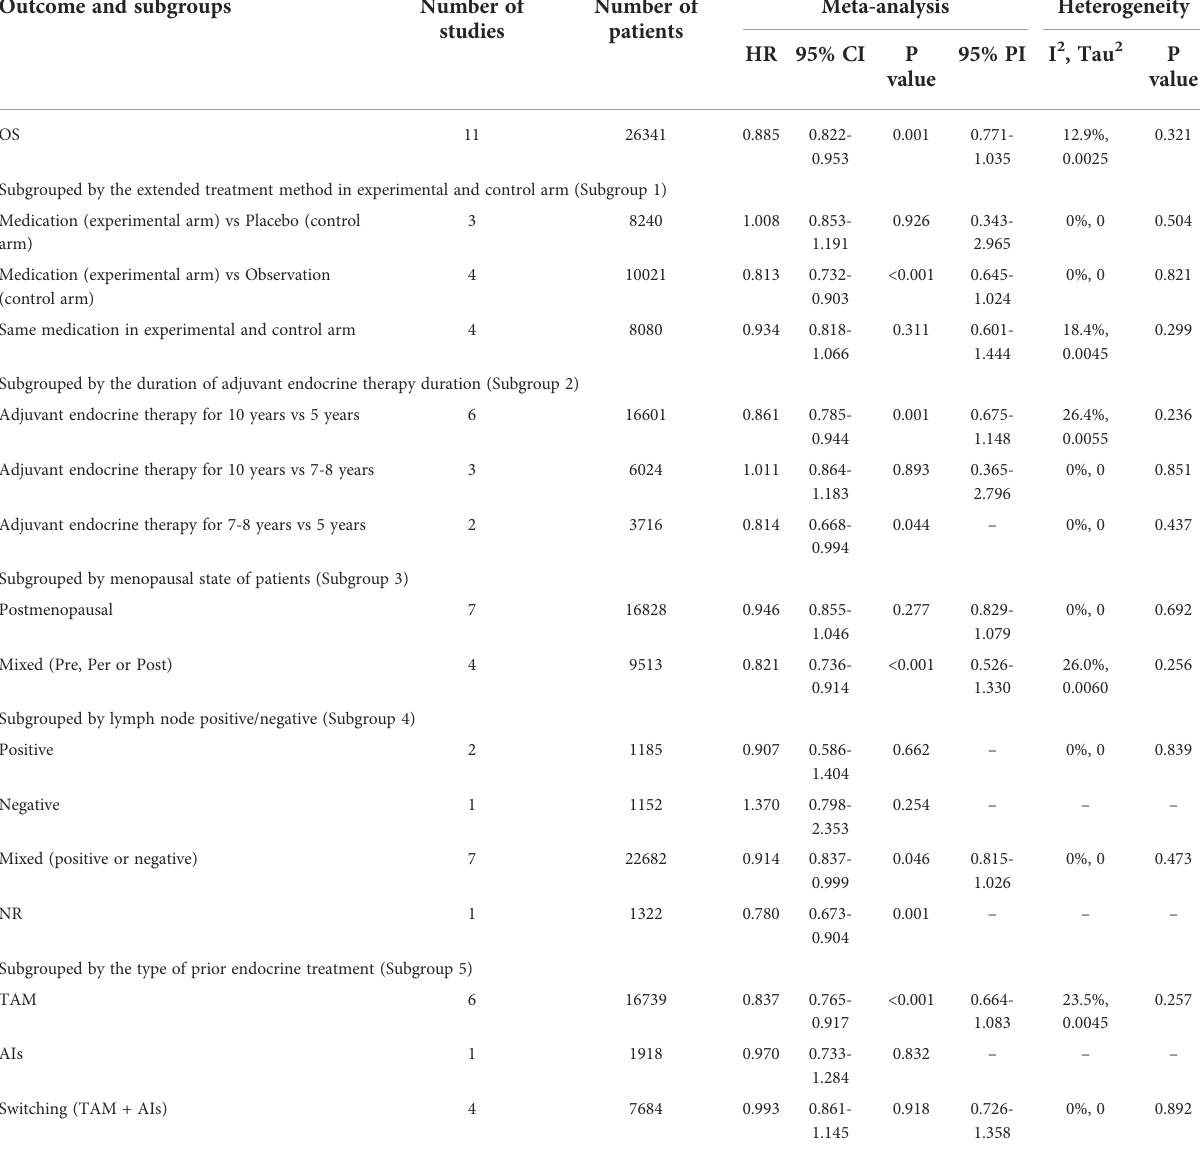
TABLE 3 Meta-analysis of OS for extended versus routinely endocrine treatment in HR+ early breast cancer. Outcome and